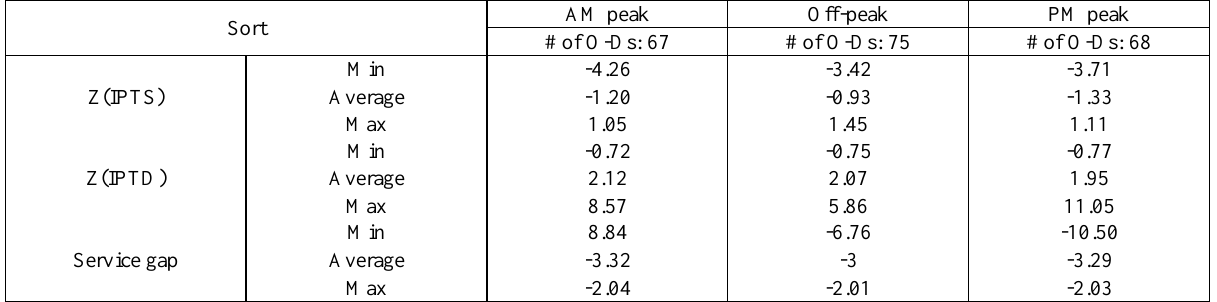
Table 2. Descriptive statistics for O-D pairs with service gap in the lower 2%